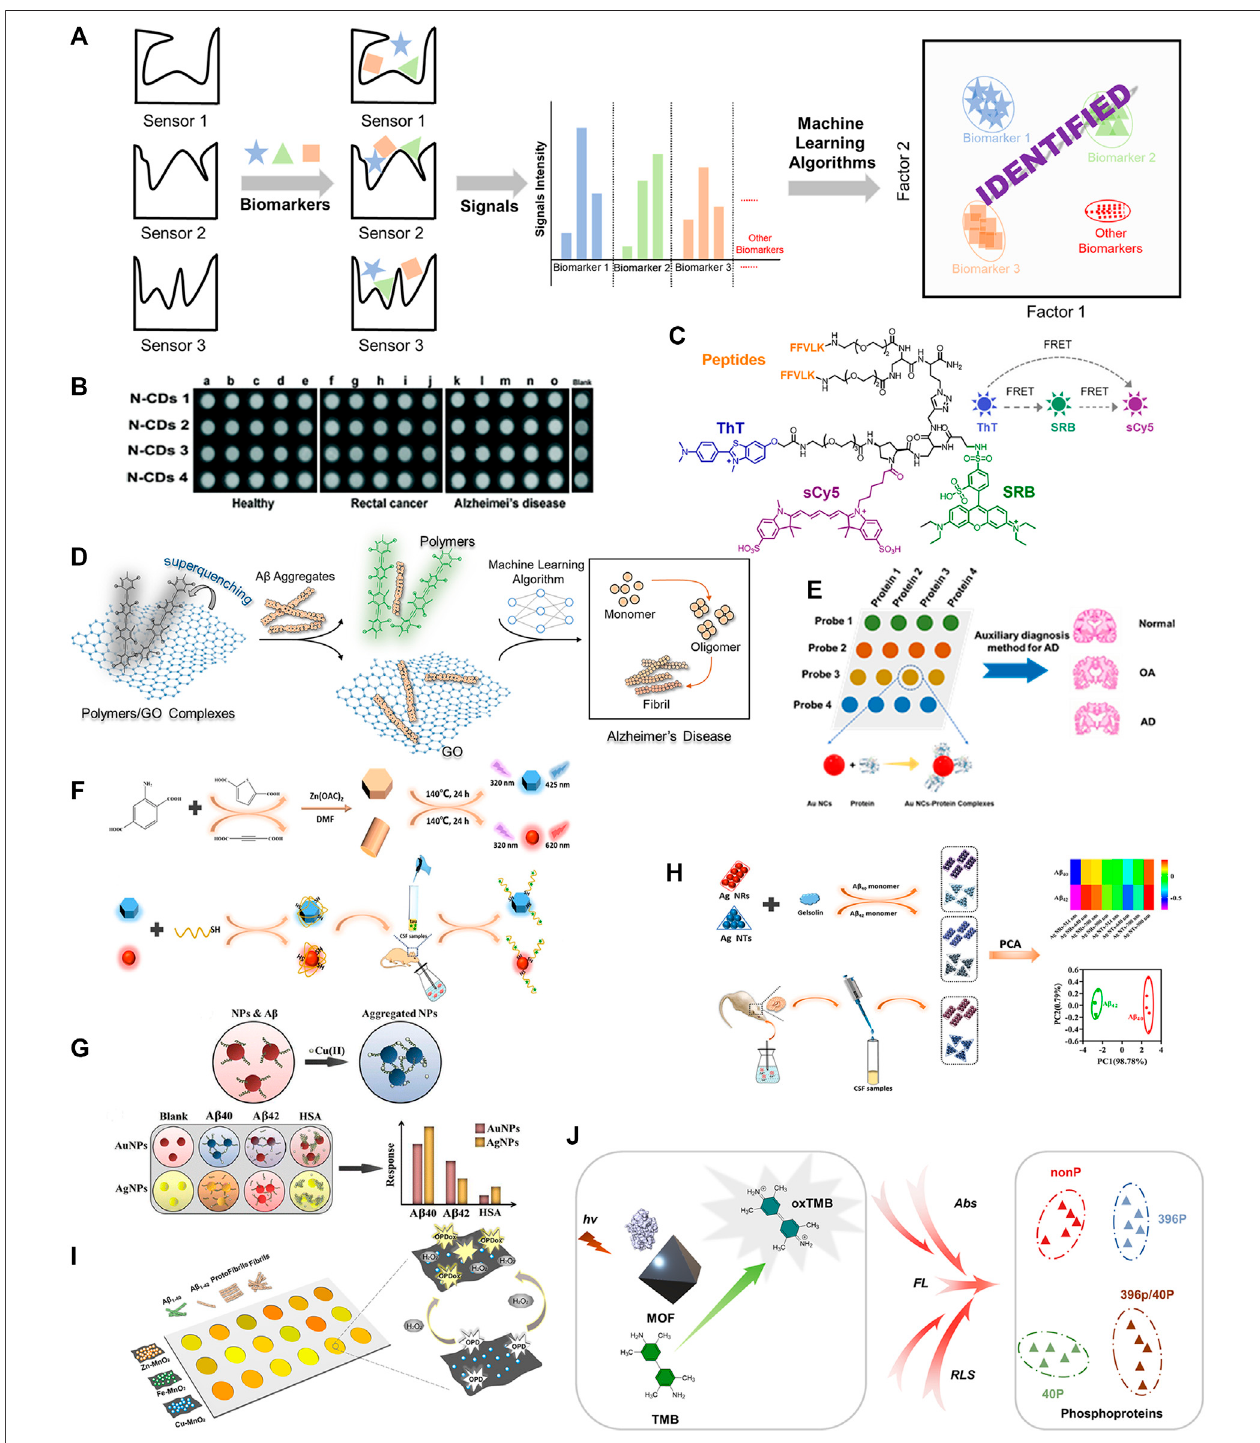
FIGURE 1 | (A) Recognition principle of sensor arrays for AD biomarkers. (B) The schematic diagram of N-CDs diagnosing AD. Adapted from Xu et al. (2017) with permission.Copyright2017RoyalSocietyofChemistry. (C) Molecularstructureofcombinatorial fl uorescentmolecularsensorforADdiscrimination.AdaptedfromHatai et al. (2017) with permission. Copyright 2017 American Chemical Society. (D) Design of sensor array constructed by conjugated polymers and graphite oxide electrostatic complexes for the discrimination of A β 40/A β 42 aggregates. Adapted from Wang et al. (2022) with permission. Copyright 2022 American Chemical Society. (E) The schematic diagram of Au NCs sensor array for proteins discrimination. (F) Synthetic method for B- and R-ZnO SMPs and responding mechanism of sensor element towards analytes. Adapted from Liu et al. (2021) with permission. Copyright 2021 American Chemical Society. (G) The schematic diagram of the discrimination principle of the colorimetric sensor array. Adapted from Ghasemi et al. (2018) with permission. Copyright 2018 Royal Society of Chemistry. (H) The